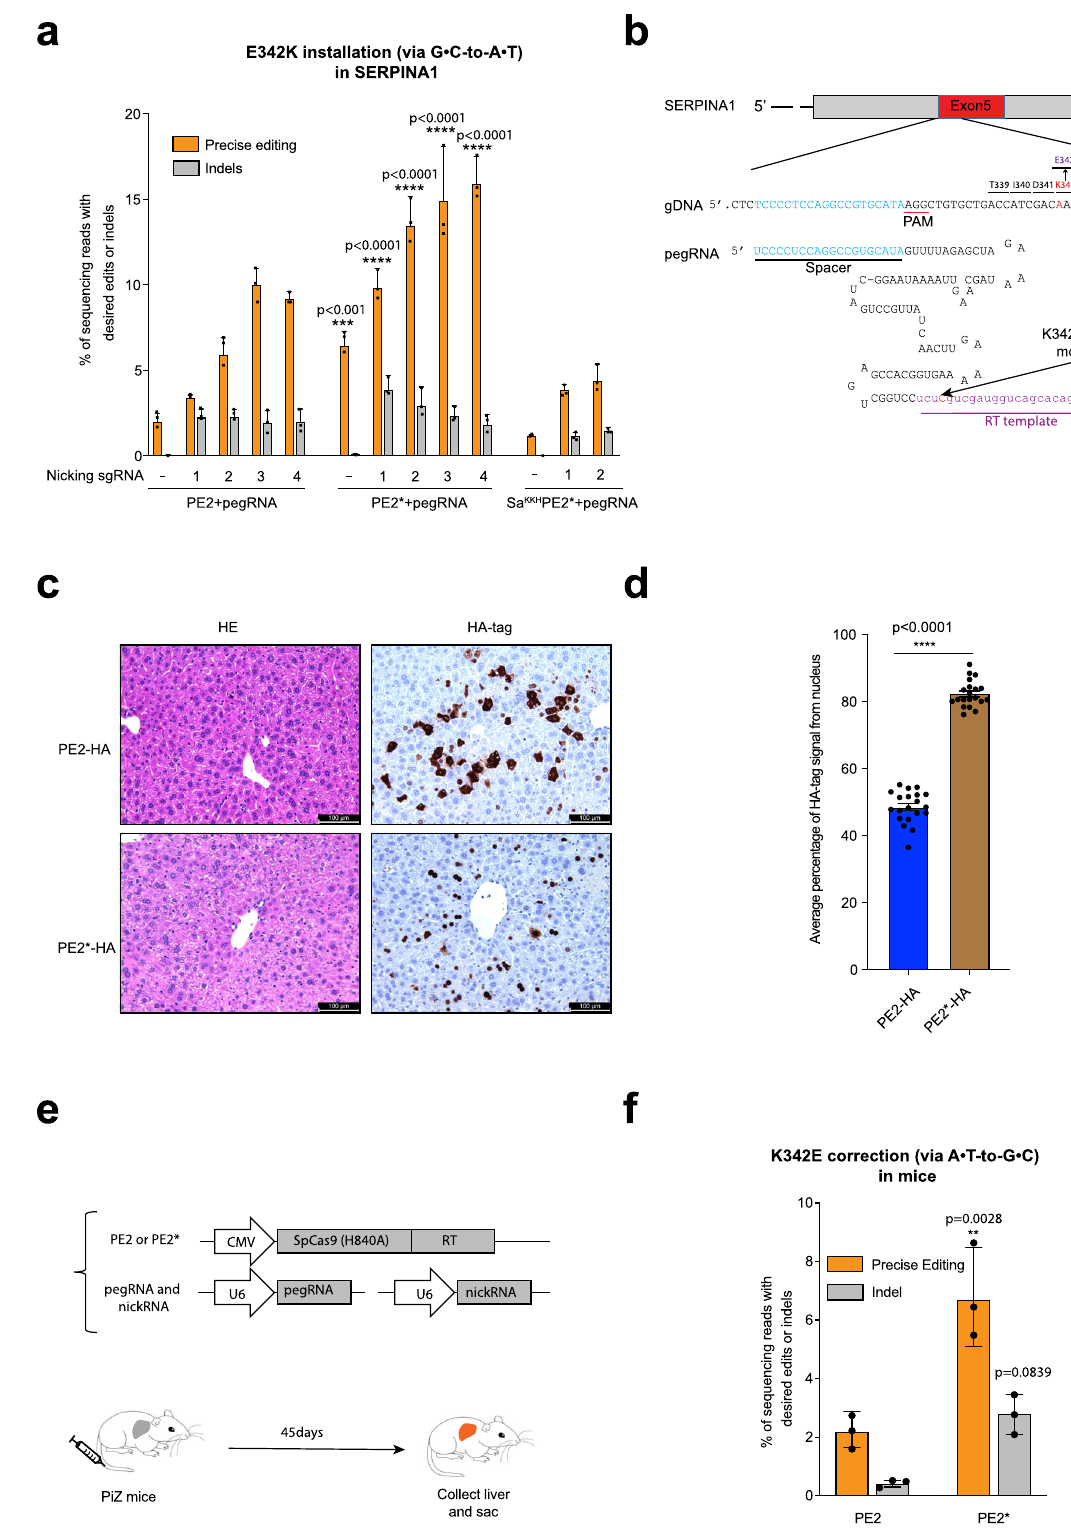
of 10.0 ± 2.7 tumors on the liver (Fig. 4c, d). Consistent with the gain of function of the S45F mutation, liver tumors were positive for nuclear β -Catenin 14 (Supplementary Fig. 5). Sanger sequence of gDNA from the tumor nodules showed precise conversion of S45F in Ctnnb1 (Fig. 4e).